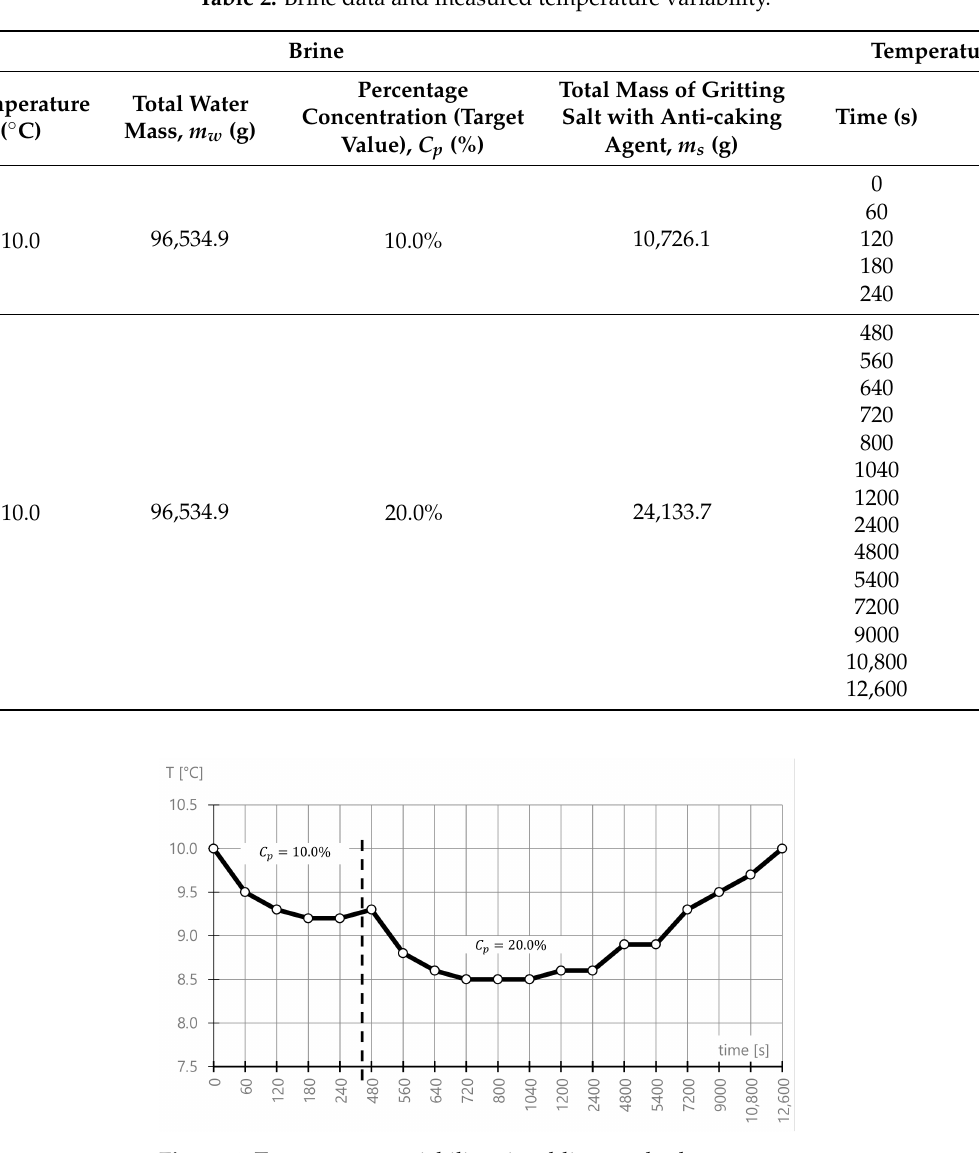
Figure 4. Temperature variability via adding road